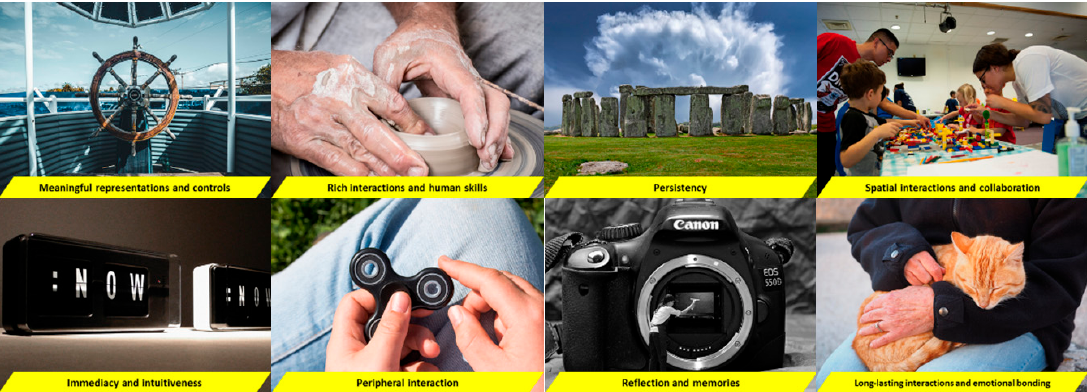
Figure 3. Tangible properties cards (front side).